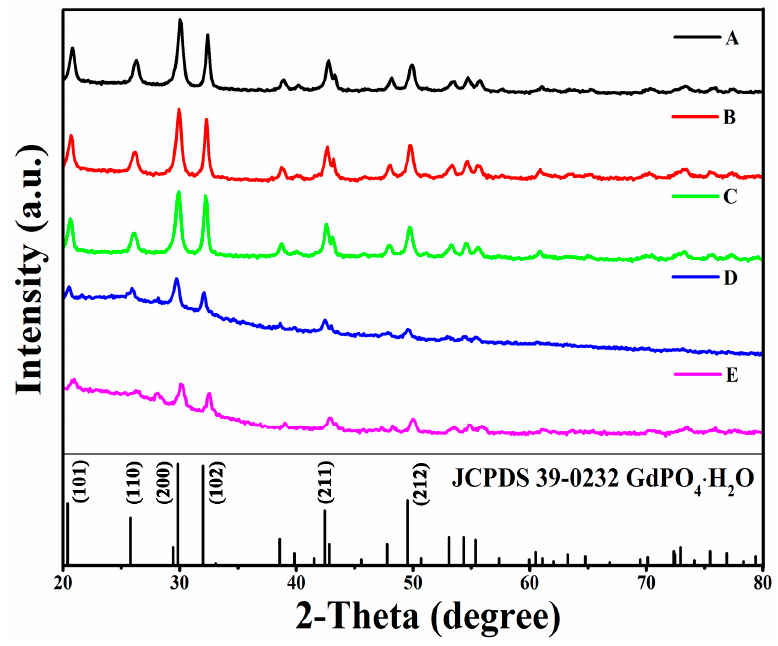
Figure 4. XRD spectra of GdPO 4 · H 2 O@SiO 2 (A) and the modified products synthesized with different proportions of GdPO 4 · H 2 O@SiO 2 –APS:NCA = 1:0.125 (B), 1:0.25 (C), 1:0.5 (D) and 1:1 (E).